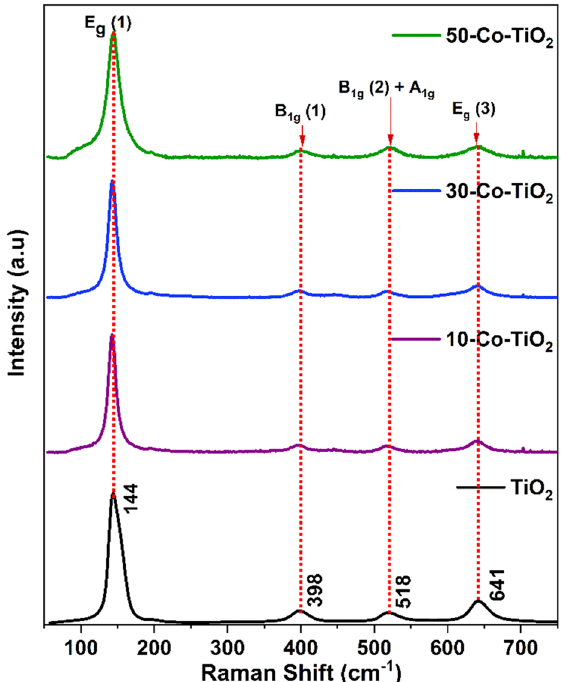
Figure 4. Room-temperature Raman spectra of pristine and doped TiO 2 .